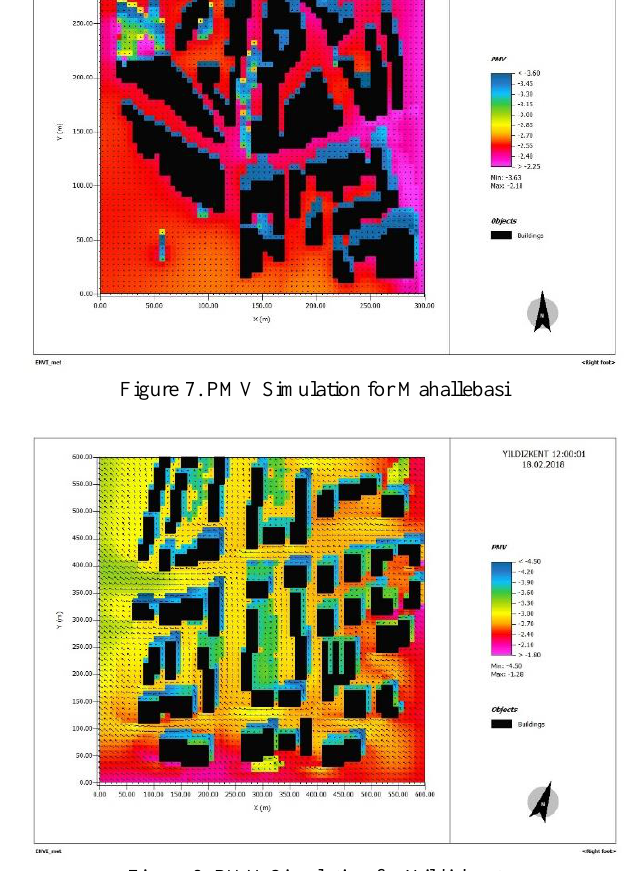
Figure 8. PMV Simulation for